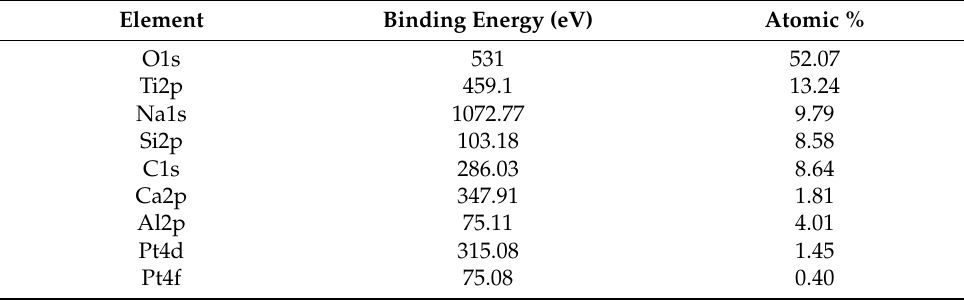
Table 5. Binding energy and the atomic % of